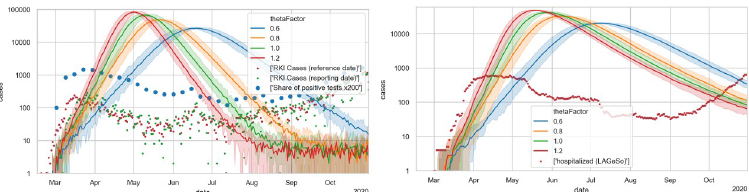
Fig 4. Unrestricted base case. LEFT: Case numbers. The green and red dots denote case numbers as reported by Robert Koch Institute [77]; the blue dots denote positive test fractions [78] multiplied by 200. RIGHT: Hospital numbers. Each simulation curve is averaged over 10 independent Monte Carlo runs with different random seeds; the shaded areas denote 5% and 95% percentiles of those 10 runs.